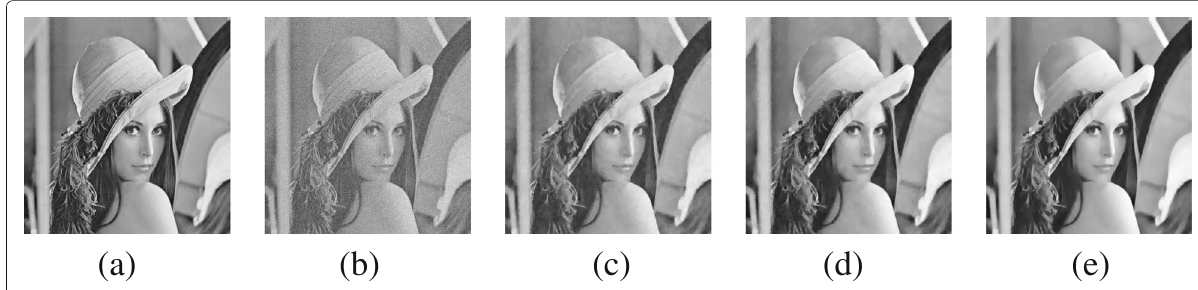
Fig. 2 Reconstructed results on Lena; a original image; b Lena image corrupted with additive Gaussian noise with σ = 20; c restored image by method M1; d restored image by method M2; e restored image by method